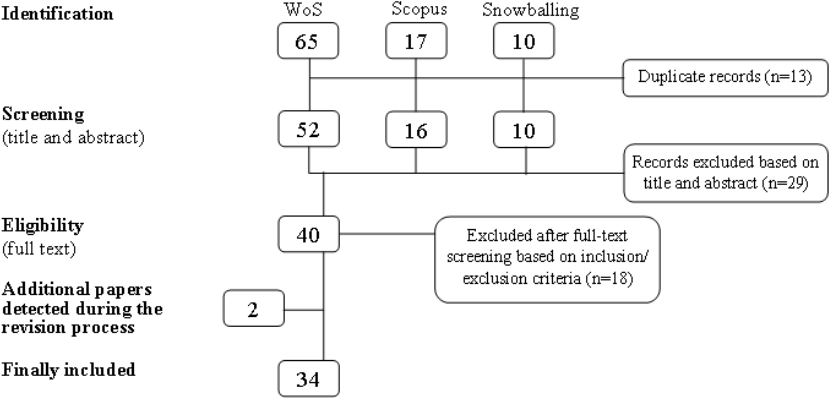
Figure 1. Flow chart of the screening process. WoS, Web of Science.